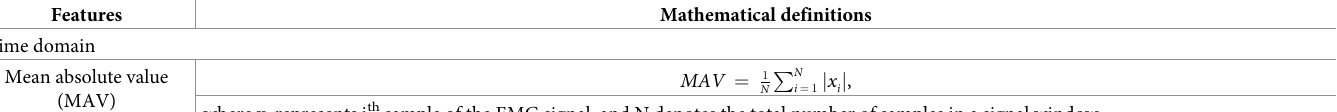
Table 1. Mathematical definitions of EMG